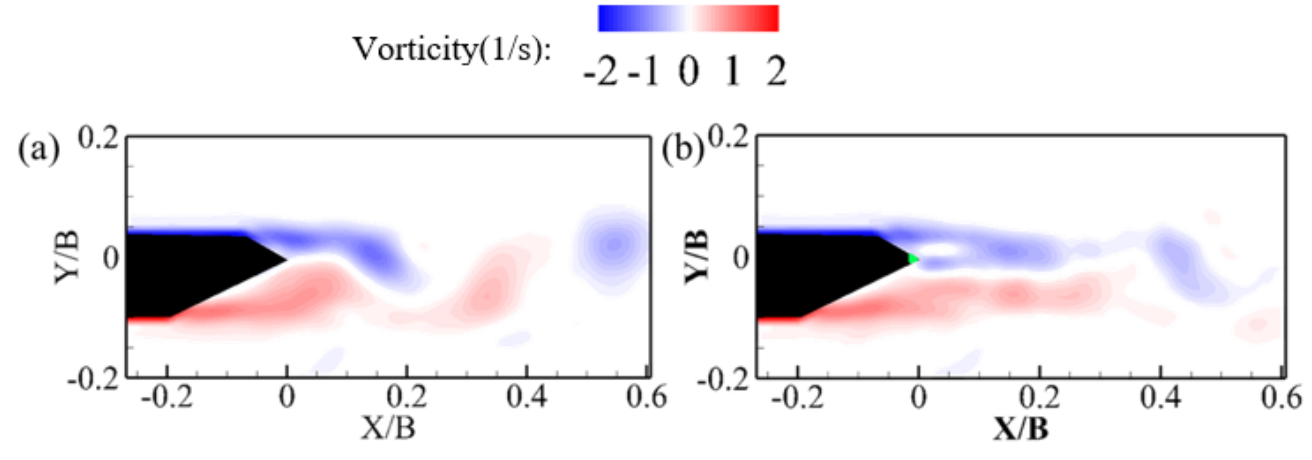
Figure 8. Instantaneous vortex shedding behind SBG model. ( a ) J sj = 0, ( b ) J sj = 0.0094.